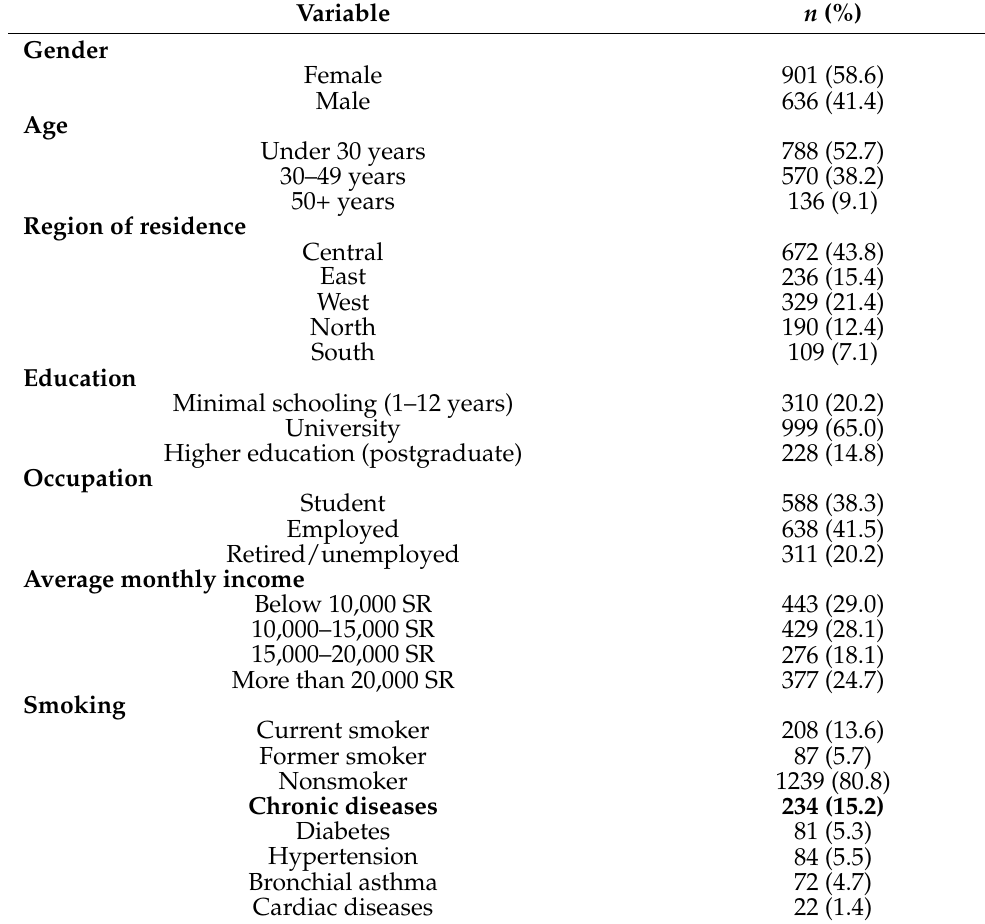
Table 1. Characteristics of the study population.